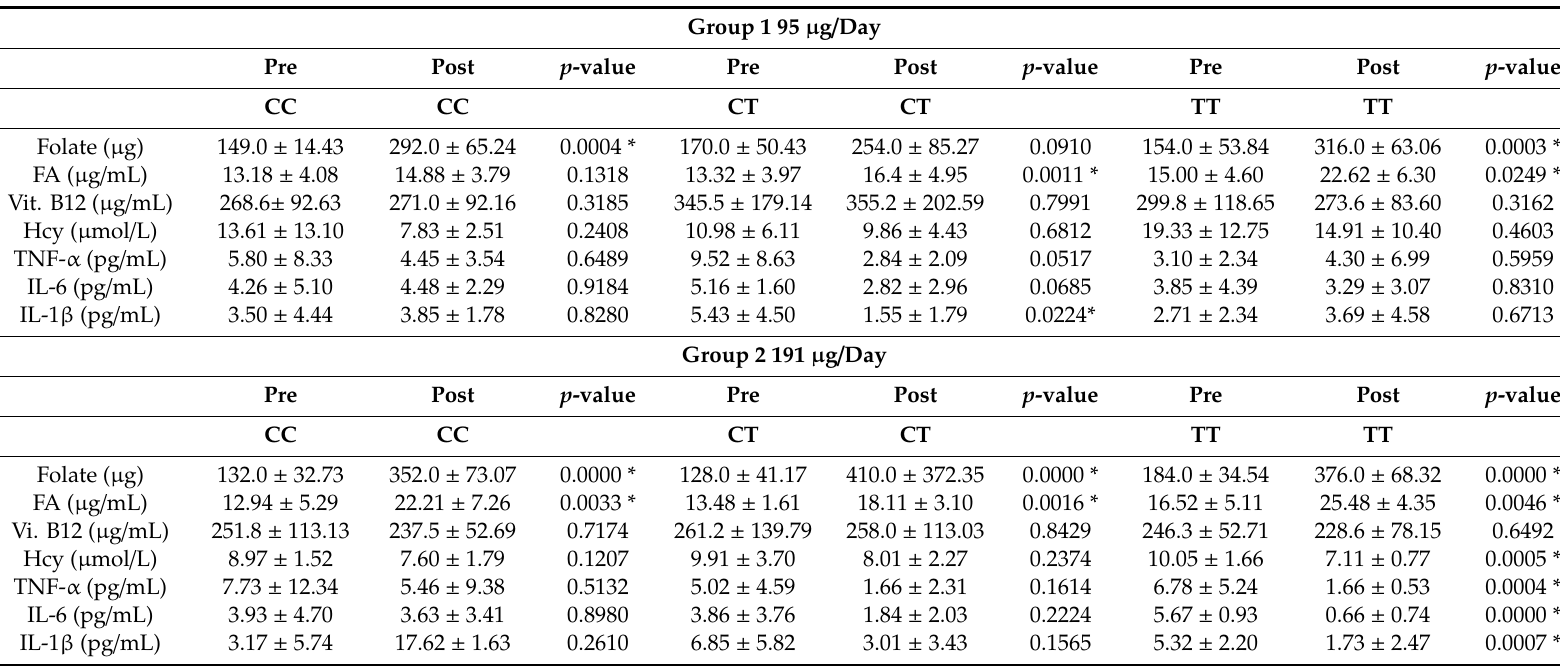
Table 4. Values of vitamins, homocysteine, and inflammatory markers, separated by the Methylenetetrahydrofolate reductase MTHFR genotypes, groups and pre and post-diet intervention with